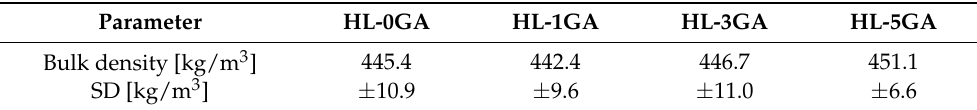
Table 5. Bulk density of hemp concretes (average values) and the standard deviation.